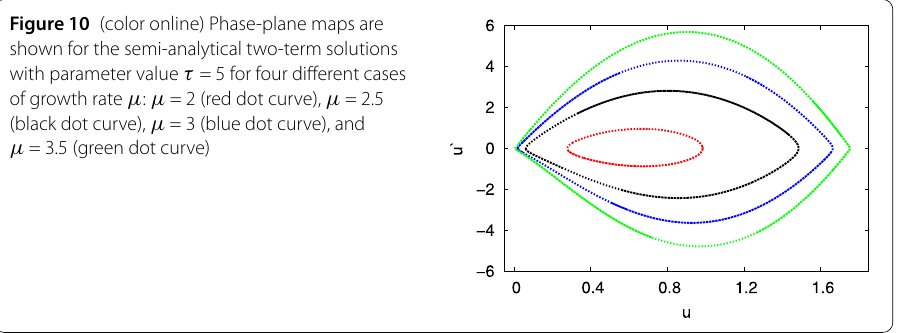
Figure 10 (color online) Phase-plane maps are shown for the semi-analytical two-term solutions with parameter value τ = 5 for four different cases of growth rate μ : μ = 2 (red dot curve), μ = 2.5 (black dot curve), μ = 3 (blue dot curve), and μ = 3.5 (green dot